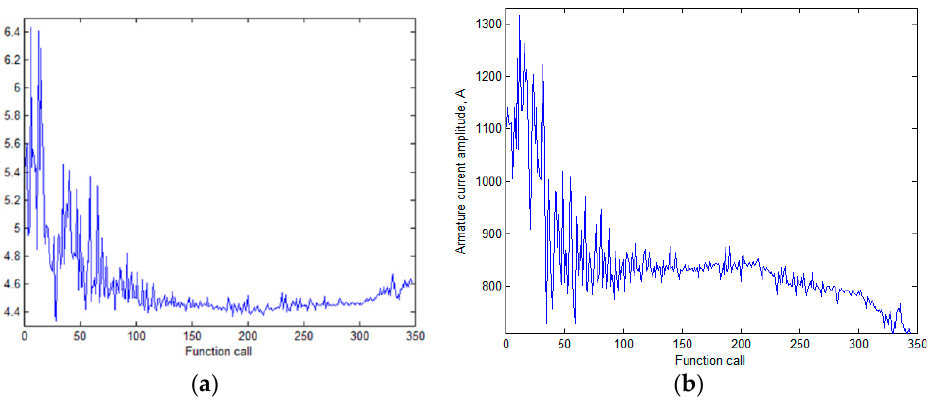
Figure 9. Change of the generator parameters during optimization: ( a ) Average losses; ( b ) Maximum magnitude of the armature winding current.